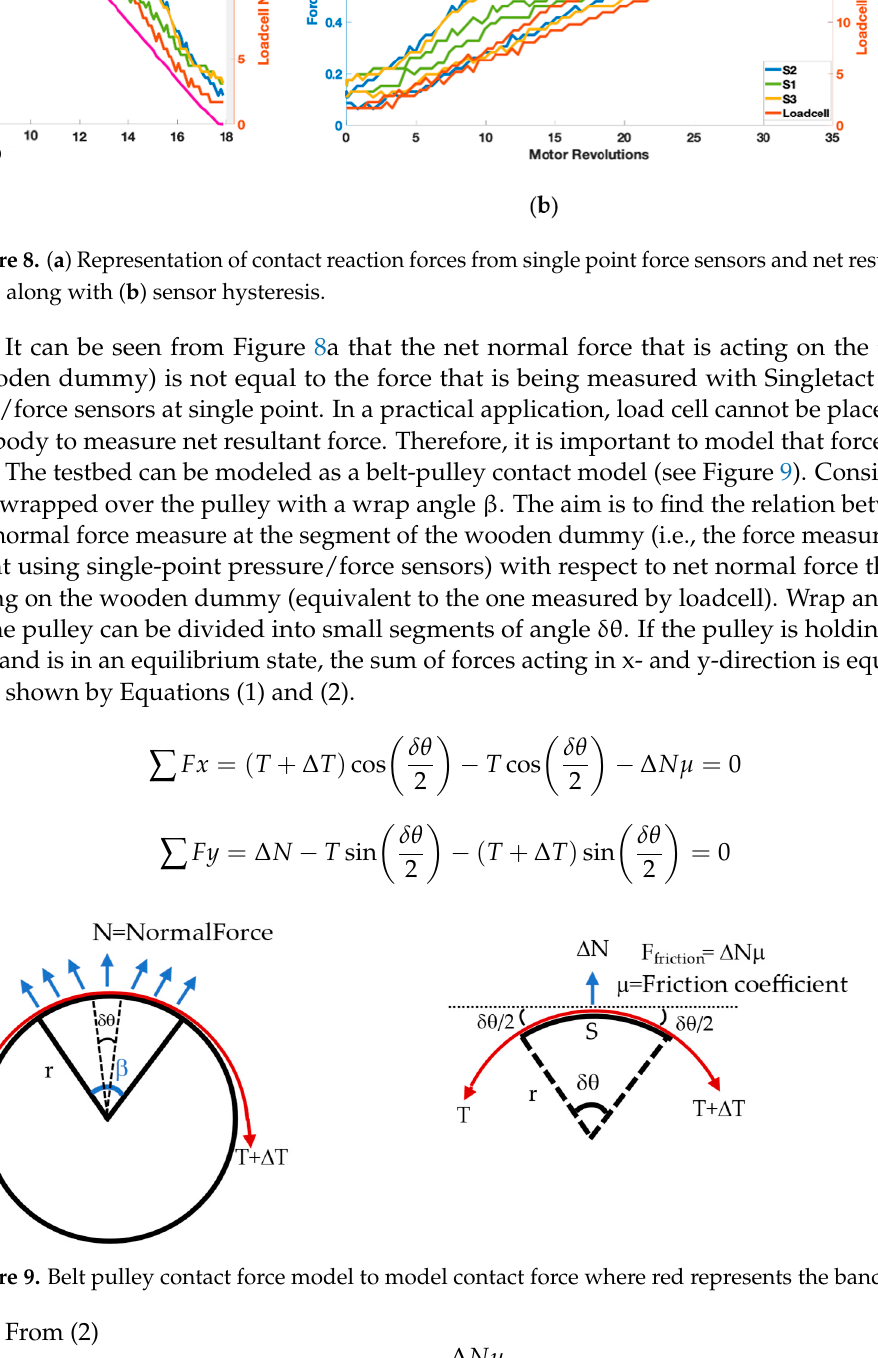
Figure 9. Belt pulley contact force model to model contact force where red represents the band. From